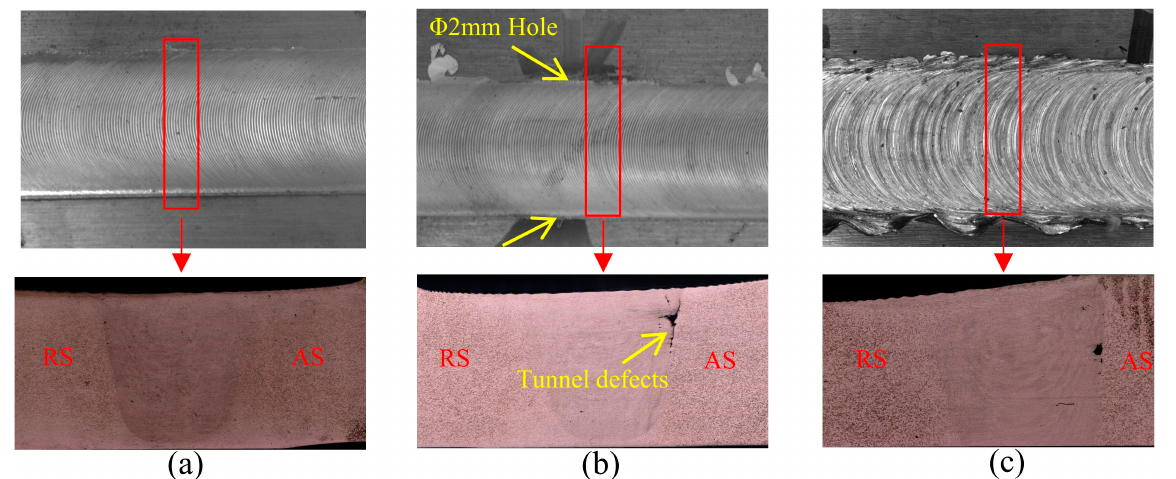
Figure 4. Weld quality of different joints: ( a ) Perfect joint (rotational speed: 1150 r/min, traverse speed: 300 mm/min); ( b ) Joint after sudden perturbation (rotational speed: 1150 r/min, traverse speed: 300 mm/min); and ( c ) Welding joint with abnormal workmanship (rotational speed: 1300 r/min, traverse speed: 100 mm/min).